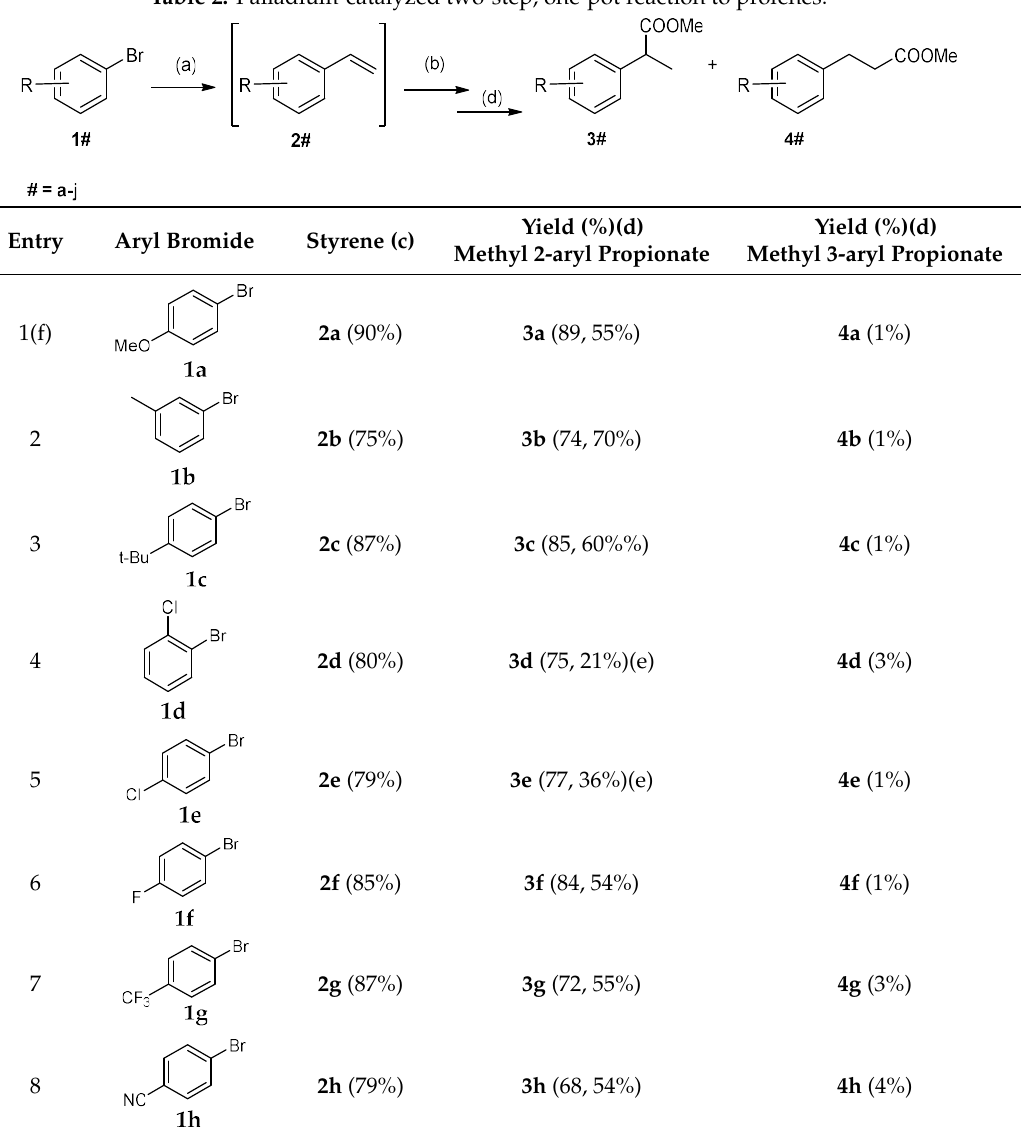
Table 2. Palladium-catalyzed two-step, one-pot reaction to profenes.